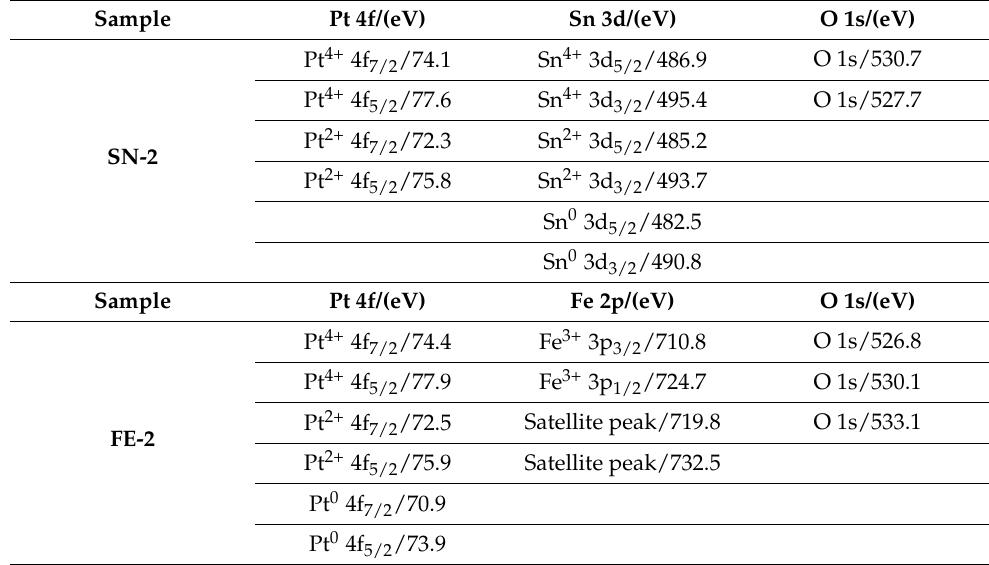
Table 2. Peak positions of deconvoluted Pt 4f, Fe 2p, O 1s and Sn 3d XPS spectra of samples SN-2 and